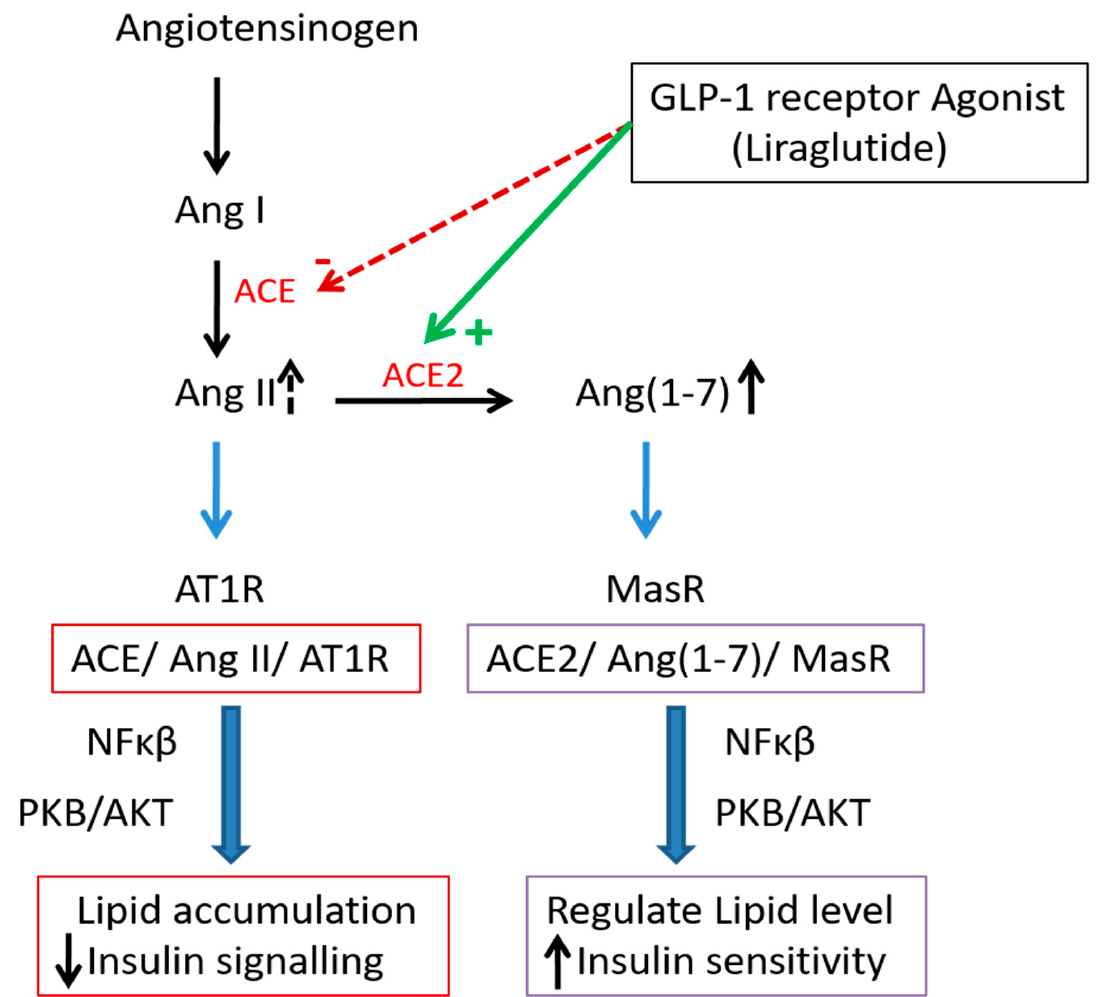
Figure 7. Role of GLP-1 receptor agonist liraglutide to regulate lipid and carbohydrate metabolism. Liraglutide lightly activates ACE/AngII/AT1 arm and markedly stimulates ACE2/Ang(1-7)/MasR.